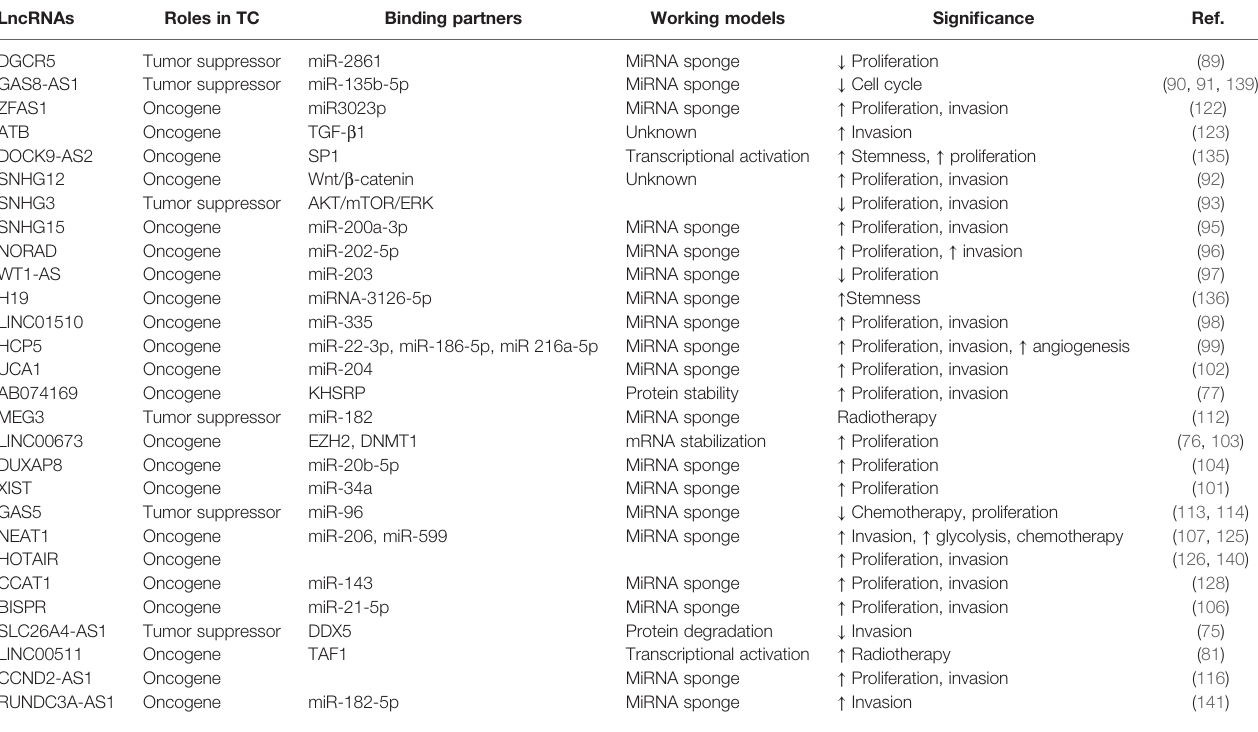
TABLE 1 | Dysregulated lncRNAs and their functions in the tumorigenesis of